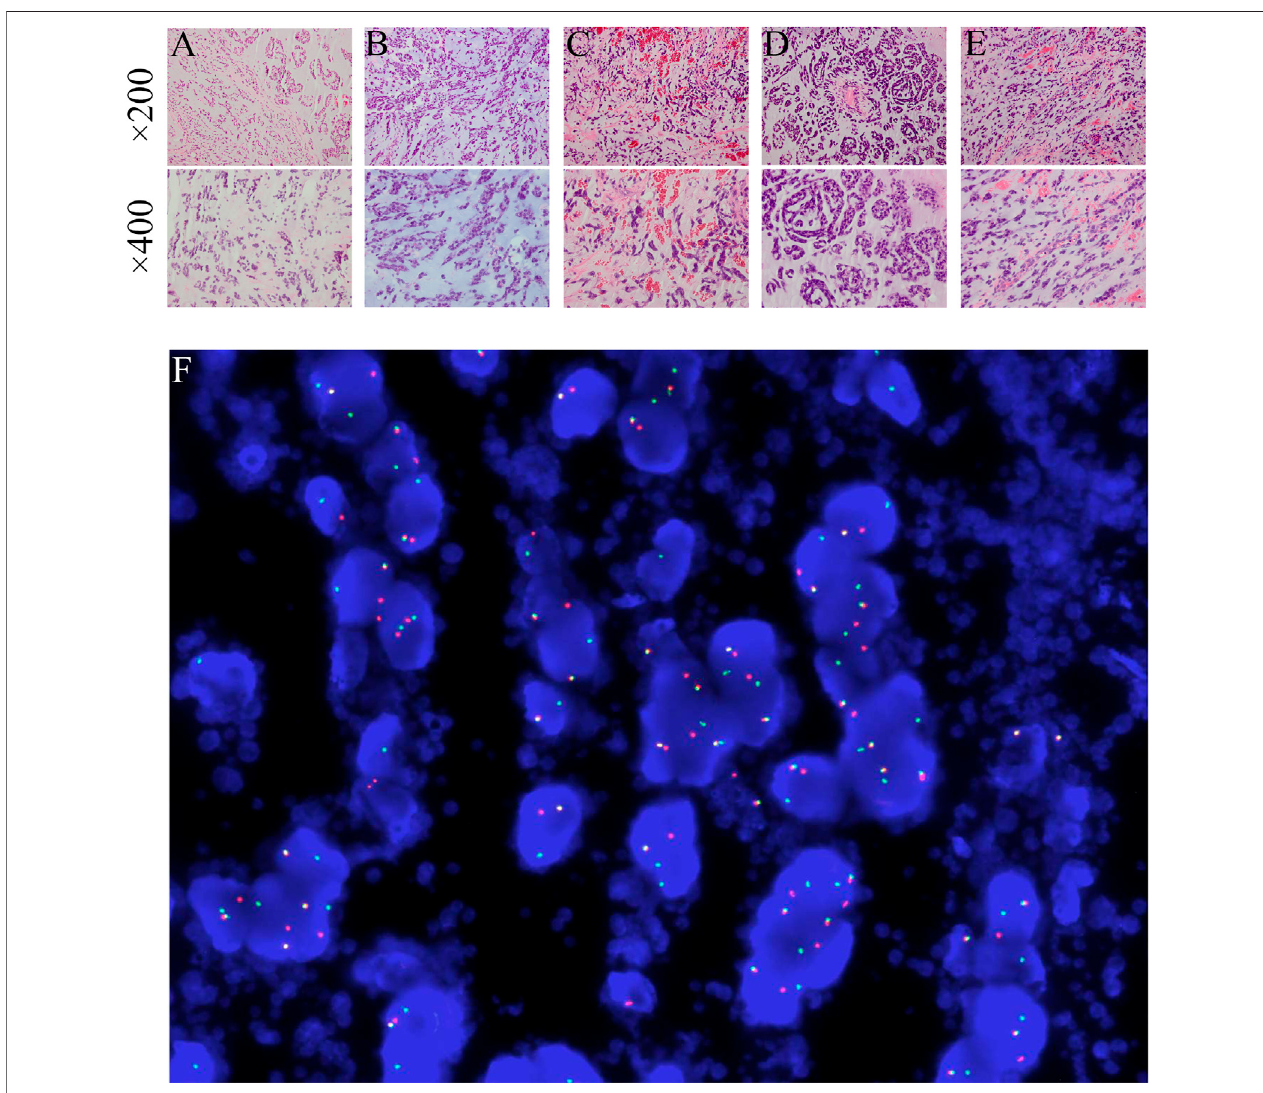
FIGURE 2 | (A – E) The pathological fi ndings of the primary and metastatic tumors obtained from fi ve surgeries (HE staining, ×200 magni fi cation and×400magni fi cation).Thepanelsexhibitacharacteristiccellularroundcelltumor withabackgroundofabundantmyxoidmatrixcomprisedwithnumerouslipoblasts. (F) NR4A3 rearrangement by break-apart FISH showing signals detected in the form of split signals (centromere, orange; telomere, green), in contrast to normal fused signals. DAPI ×